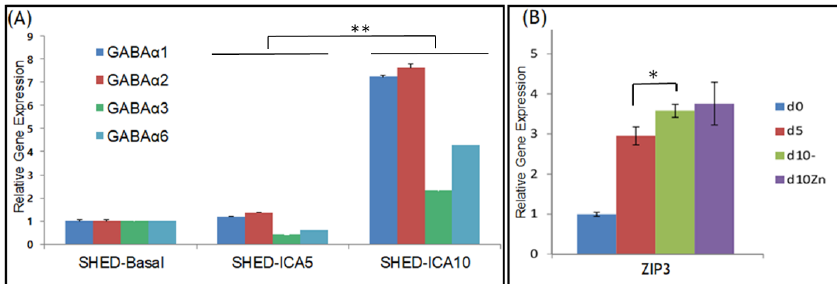
Figure 2. Relative mRNA levels of GABA A receptors α 1, α 2, α 3, and α 6 ( A ) and ZIP3 transporters ( B ) relative to 18S ribosomal RNA in stem cells from human exfoliated deciduous teeth (SHED) cells as they mature into insulin-producing and -secreting SHED β -cells. * p < 0.01, ** p < 0.0001. 3.3. ZIP3 Transporters in the Plasma Membrane of SHED β -Cells Are Functional mRNA levels for Glucose transporter 2 (GLUT2) and Insulin precursor 1 (INS1) increased as SHED β -cells matured (Figure 3A). Supplementation with zinc significantly increased the expression of GLUT2 and INS1. Results of Western blot analysis indicated that ZIP3 transporters were present in the plasma membrane (Figure 3B). Using siRNA, we confirmed that ZIP3 transporters in the plasma membrane were functional. Results of ELISA assays for insulin levels and zinc contents indicated that siZIP3 partially reduced insulin secretion by SHED β -cells. Intracellular zinc concentrations showed a significant decrease in ZIP3 siRNA transfectants compared to SCR (scrambled) transfectants (Figure 3C). In the same culture, the amount of insulin secreted into the medium was also significantly reduced in the siZIP3 transfectants compared with the SCR transfectants (Figure 3D). These results suggest that insulin production by SHED β -cells may depend on the zinc concentration in the cytosol as well as the total amount of ZIP3 protein in the cells.